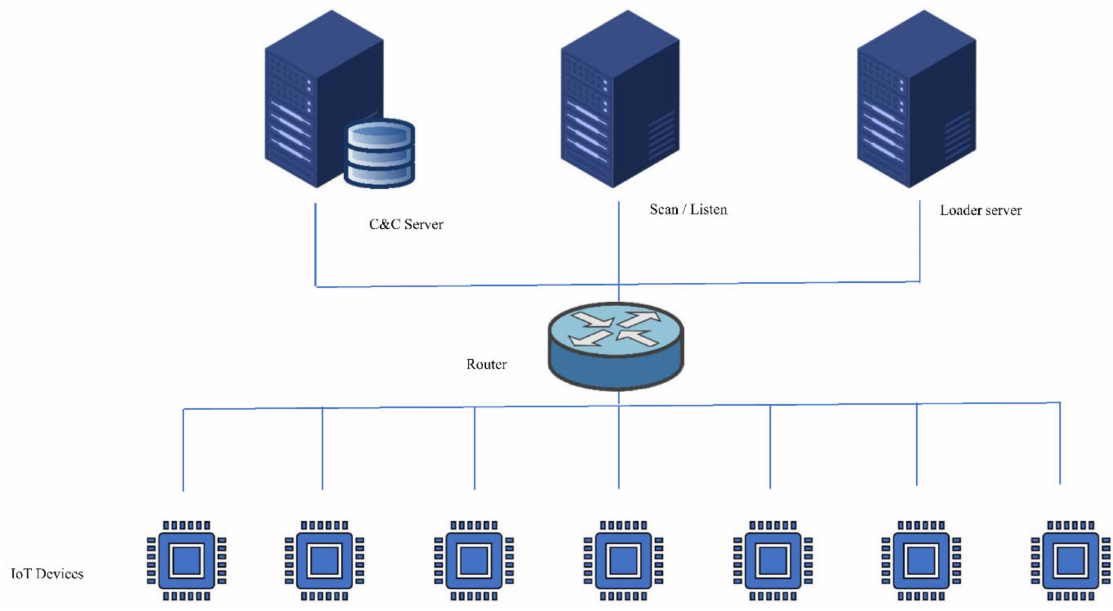
Figure 5. The architecture of the used testbed to simulate and analyse the behaviour of IoT